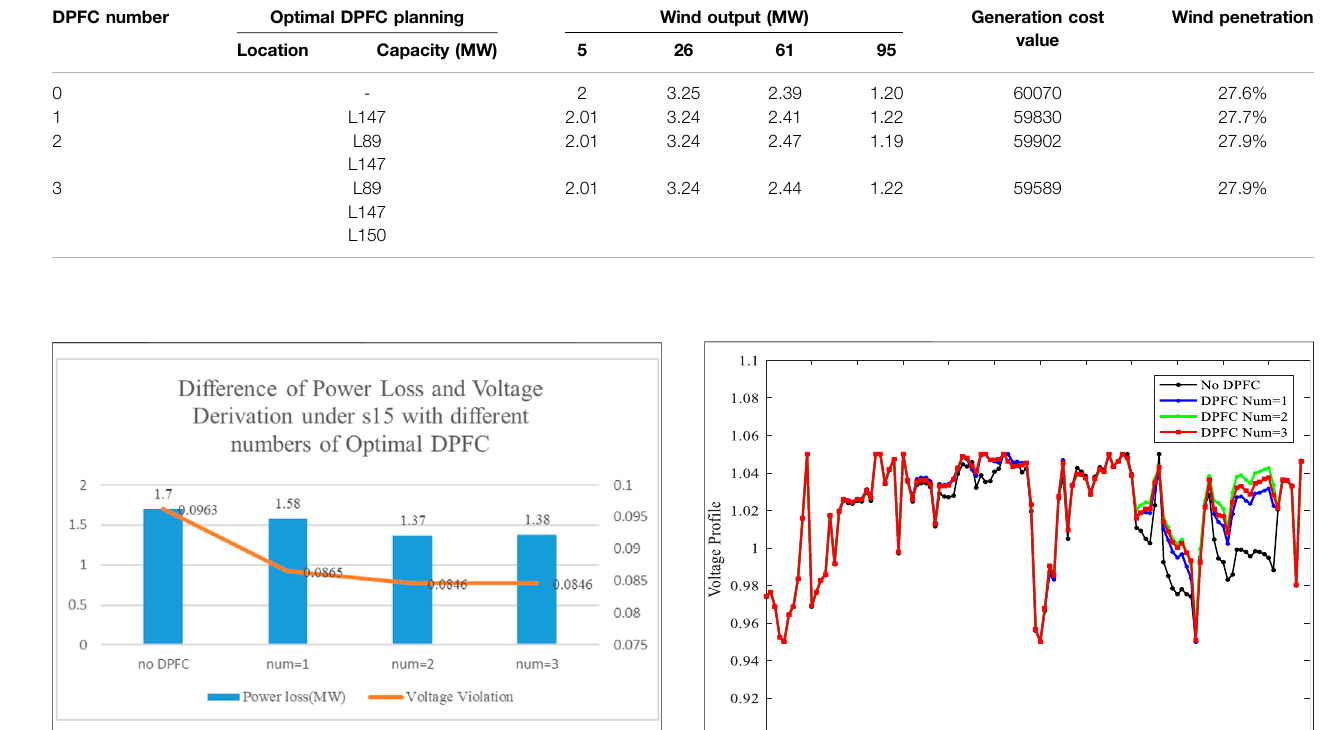
TABLE 3 | Solution of optimal DPFC with the constant capacity of DPFC.